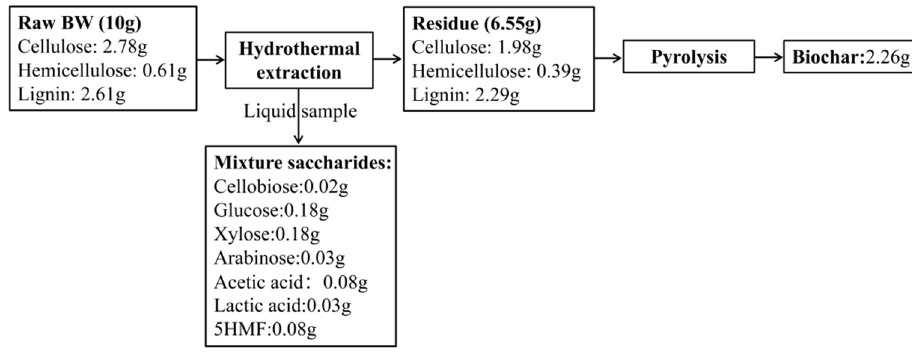
Figure 8. The evaluation of the biomass conversion of the two-stage thermal-chemical process.